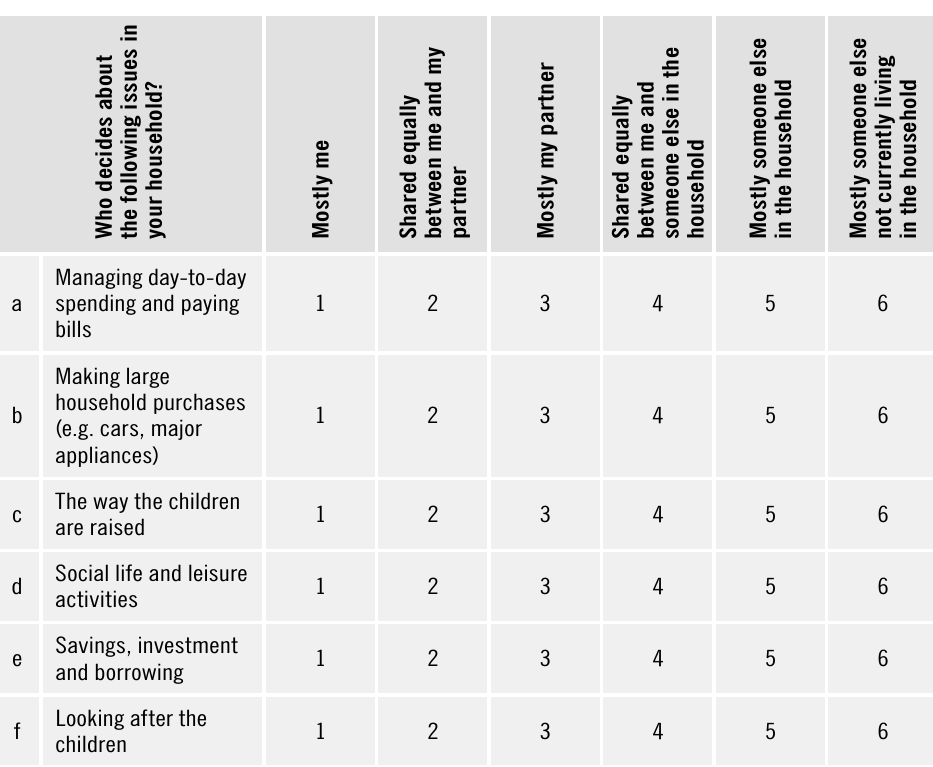
Table 2. The fragment of the LiTS III